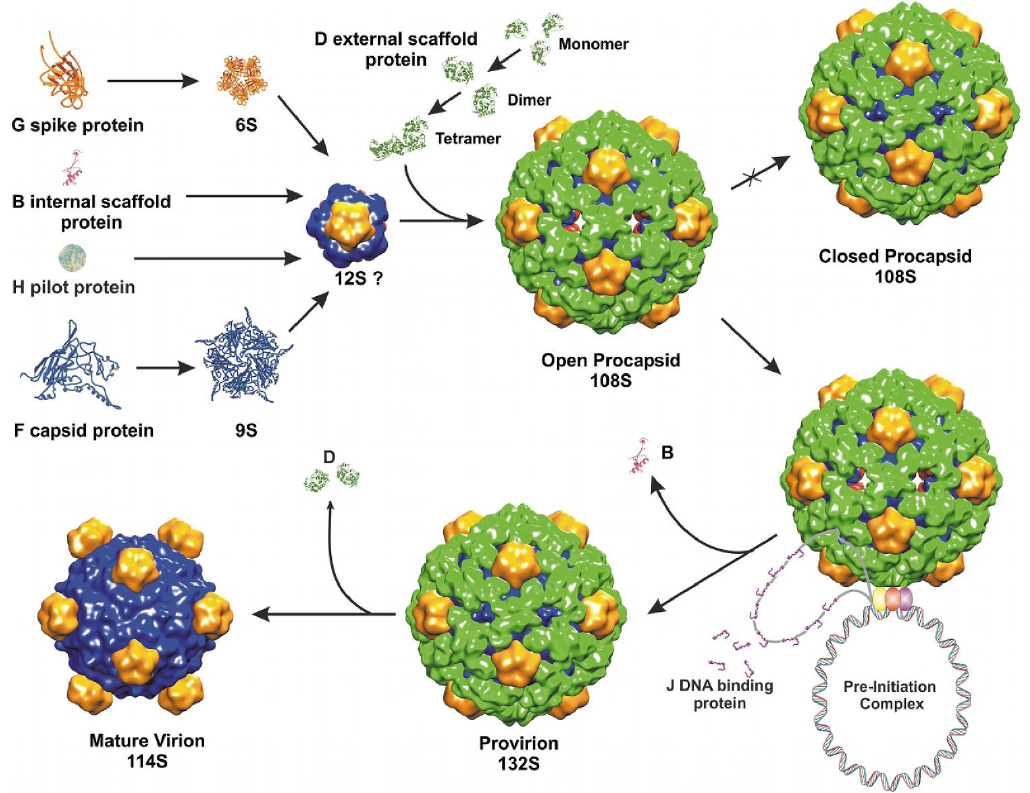
Figure 3. Microviridae assembly pathway (reprinted from Bernal et al. [189] with permission from